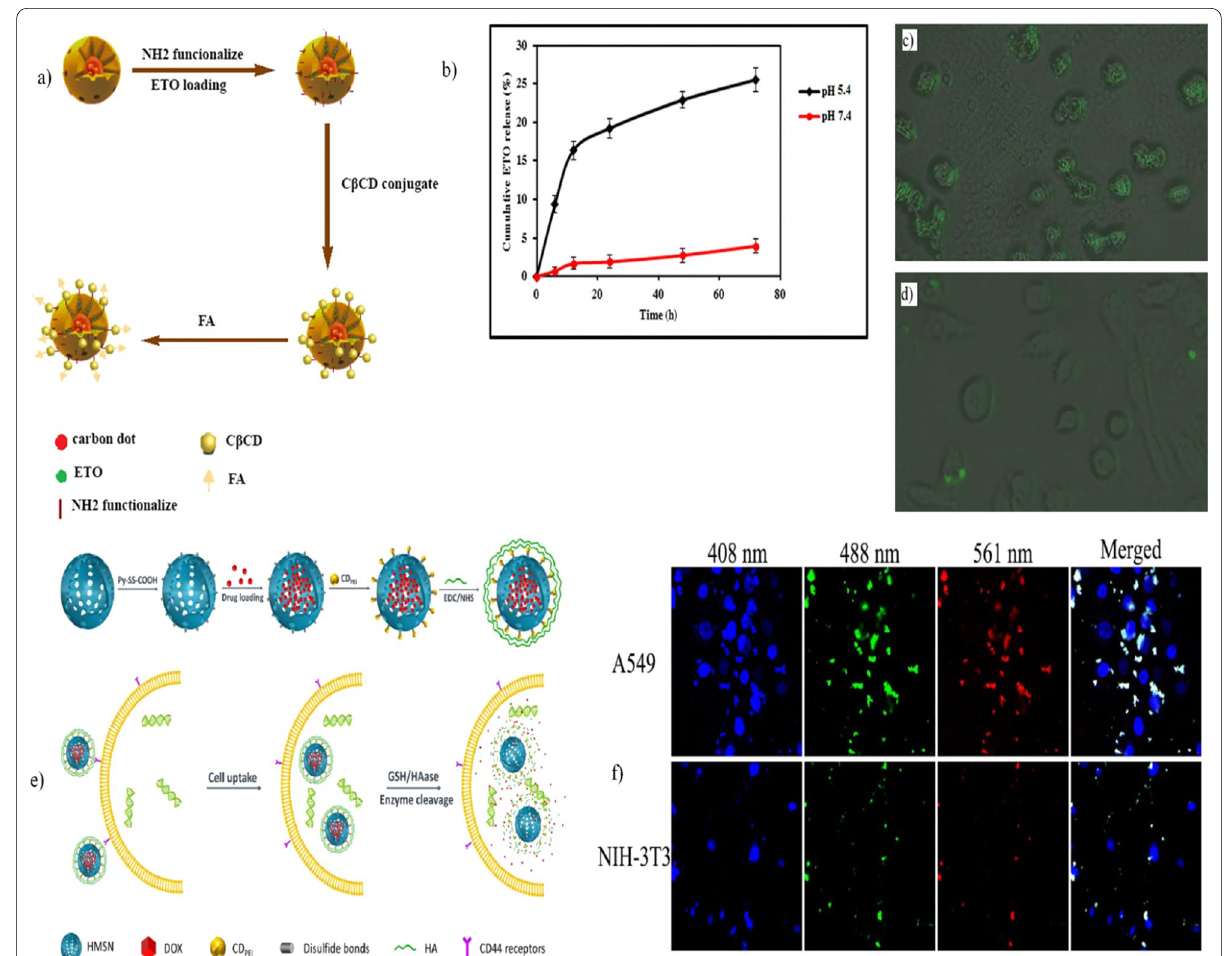
Fig. 6 a Scheme of the formation of pH‑responsive nanocarriers for drug delivery and bioimaging, b graph of drug release at different pH values of 5.4 and 7.4, c , d fluorescence images of endocytosis of FA‑C β CD‑MSCD‑ETO by HeLa and HepG2 cells. Adapted with permission from ref. [252] © 2018 Elsevier. e Schematic representation of nanoplatform formation, drug loading, and the mechanism of dual‑stimuli drug release. f Endocytosis of the nanoplatform by A549 and NIH‑3T3 cells. Images obtained by CLSM. Adapted with permission from ref. [225]. Copyright 2017